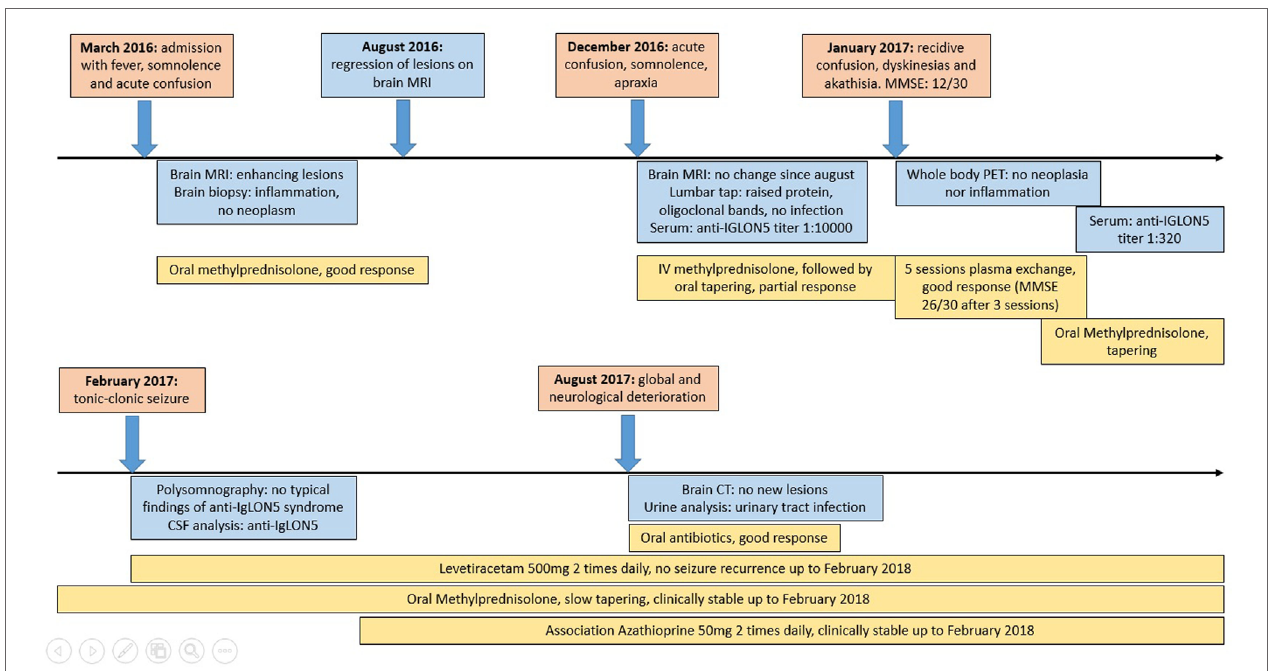
FIgURe 1 | A timeline displaying synthetically the evolution of our case: in the red boxes, the clinical events have been reported; in the blue boxes, there is a list of the significant investigations that have been performed; and in the yellow boxes, we displayed the therapies and the relative